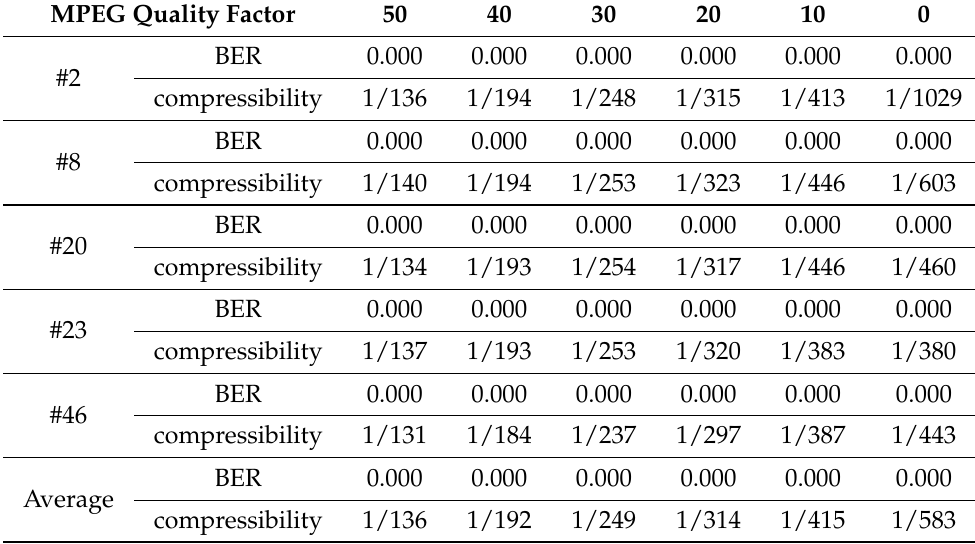
Table 6. Robustness results for the benchmark Set-6 with the watermark strength α = 1.5 (PSNR of 39.50 dB, SSIM of